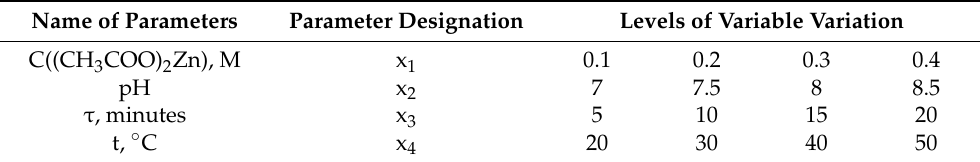
Table 4. Levels of variation of the main variable parameters.